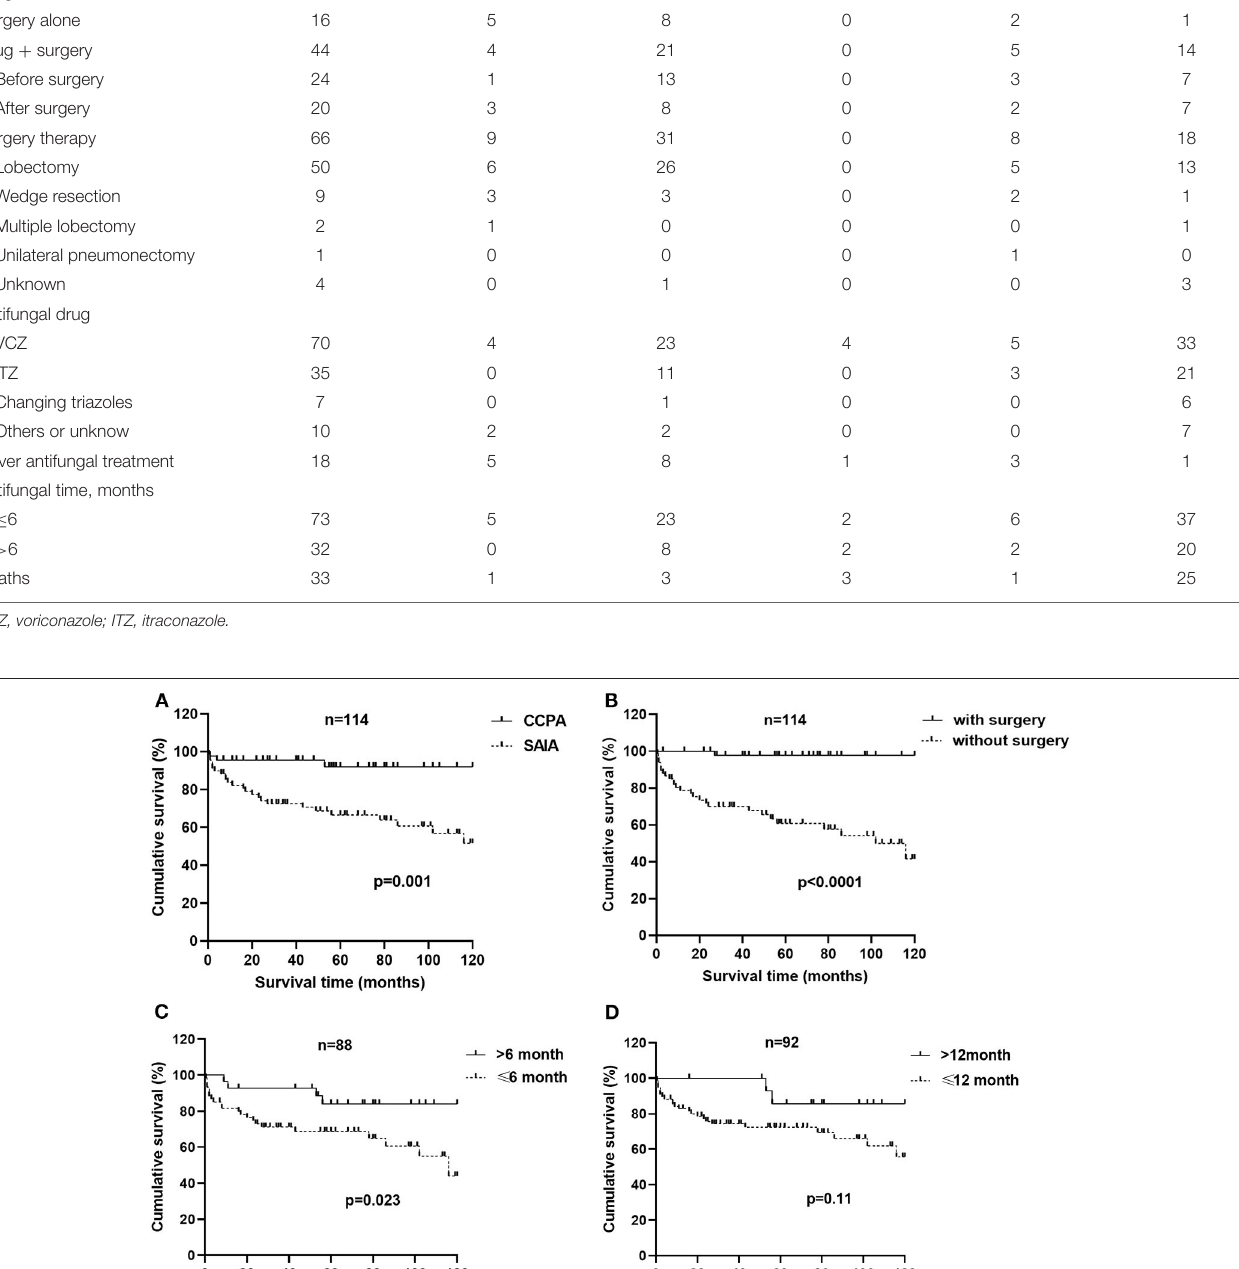
Frontiers in Medicine |